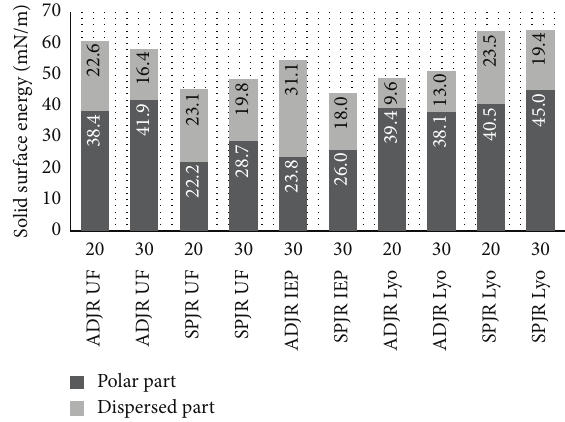
Figure 4: Young’s modulus of Jatropha -based cast films.